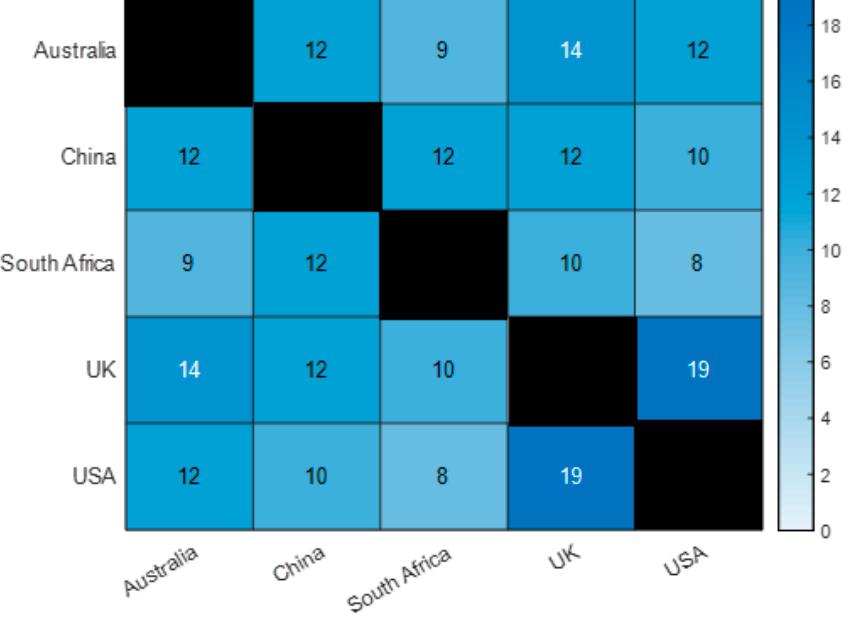
Figure 8. The number of important virulence genes shared by di ff erent